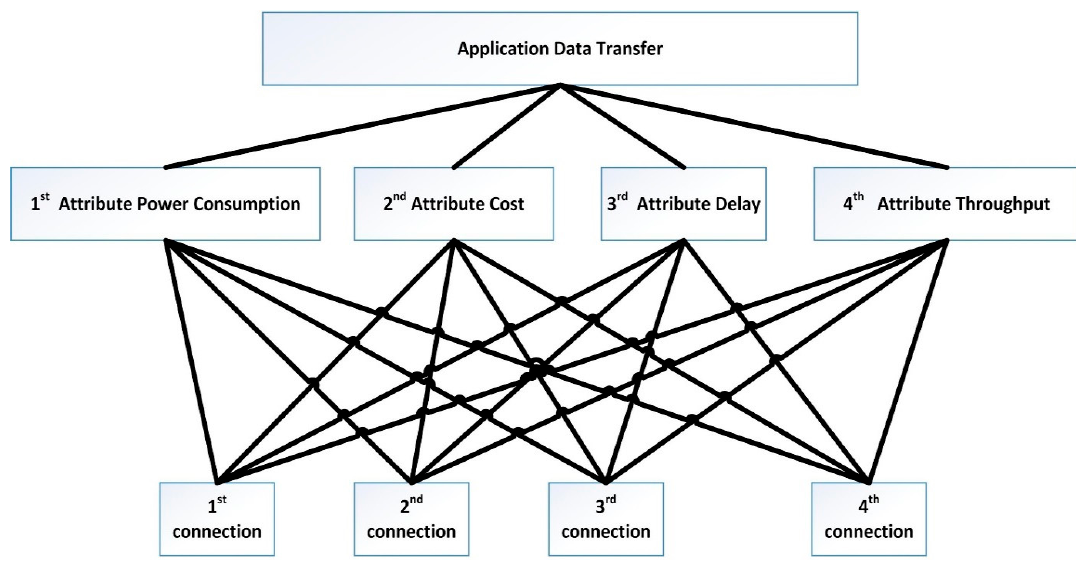
Figure 4. Hierarchy of ranking issue using MADM method.